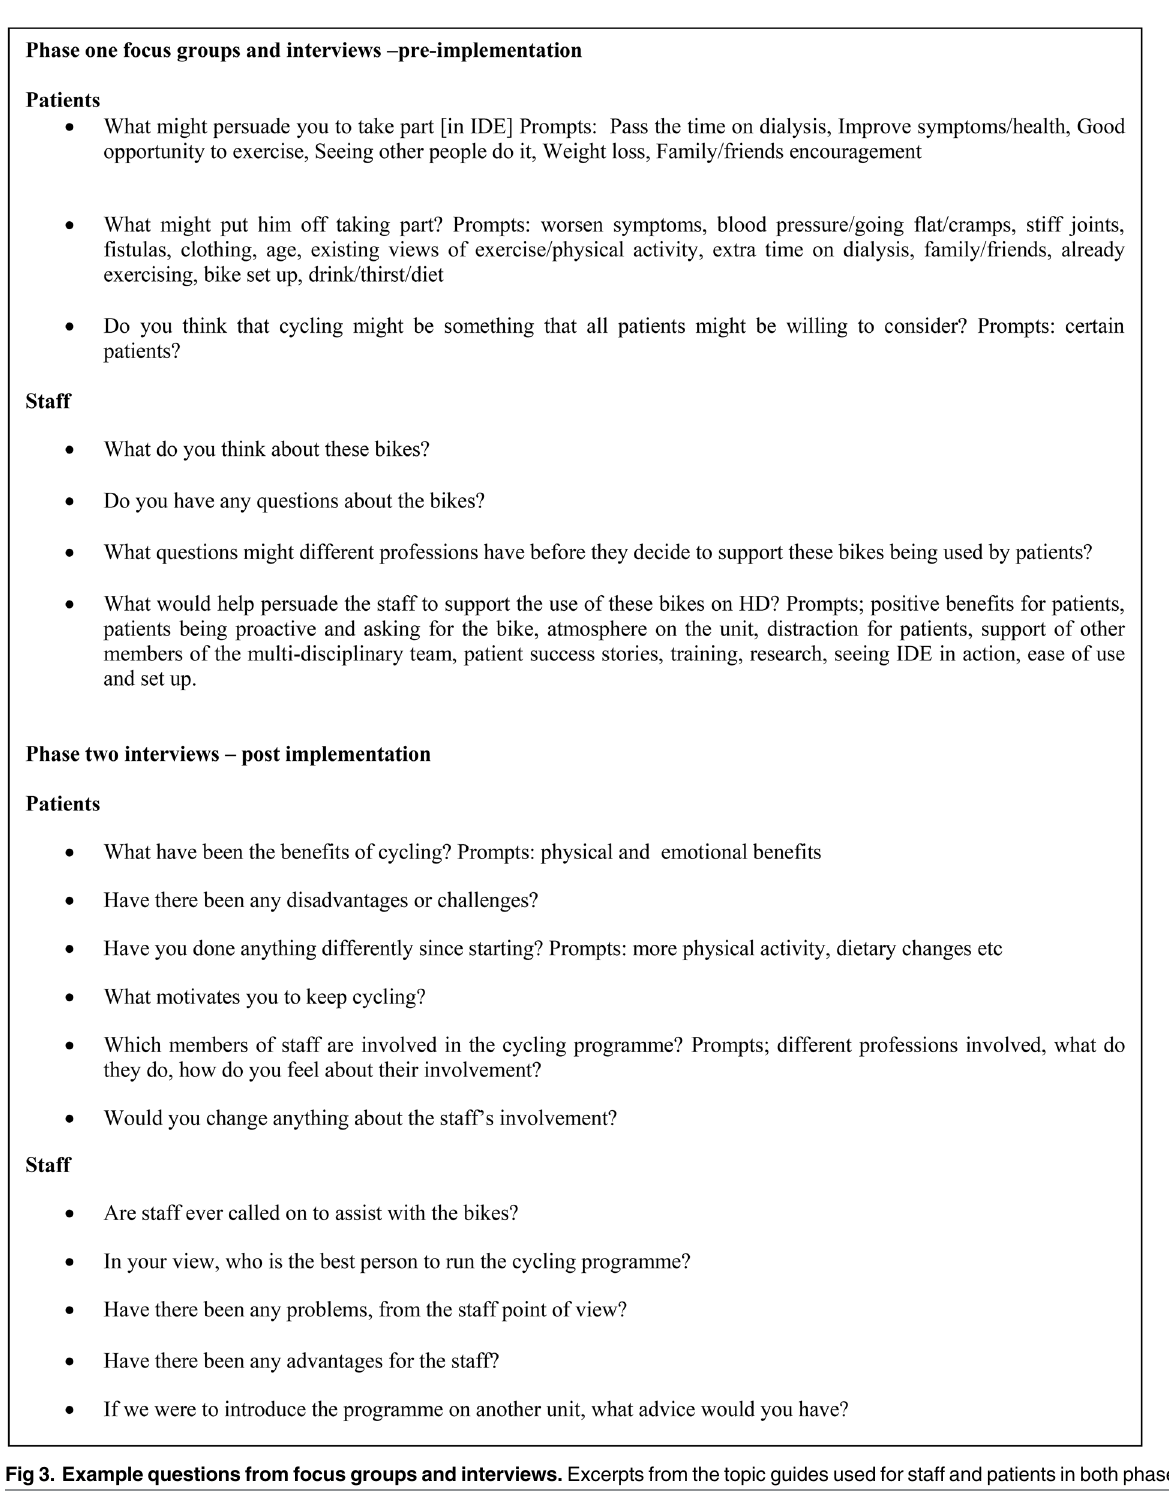
PLOS ONE | DOI:10.1371/journal.pone.0128995 June 12,